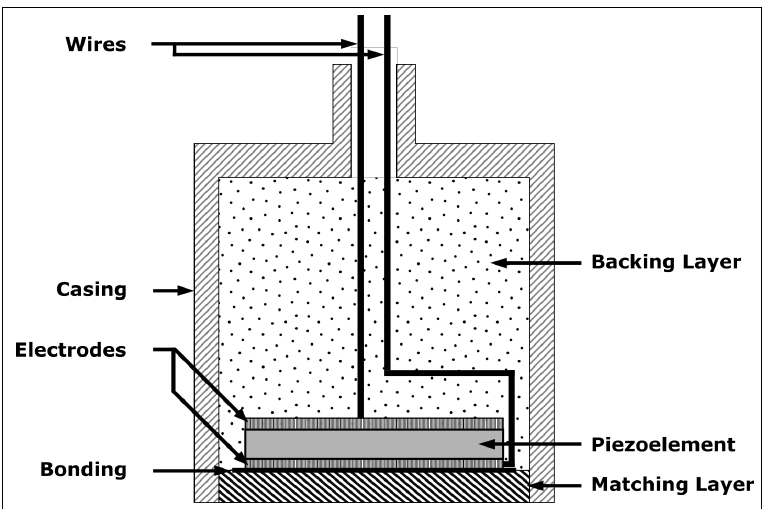
Figure 1. Schematic cross-sectional view of an ultrasonic transducer showing its components.